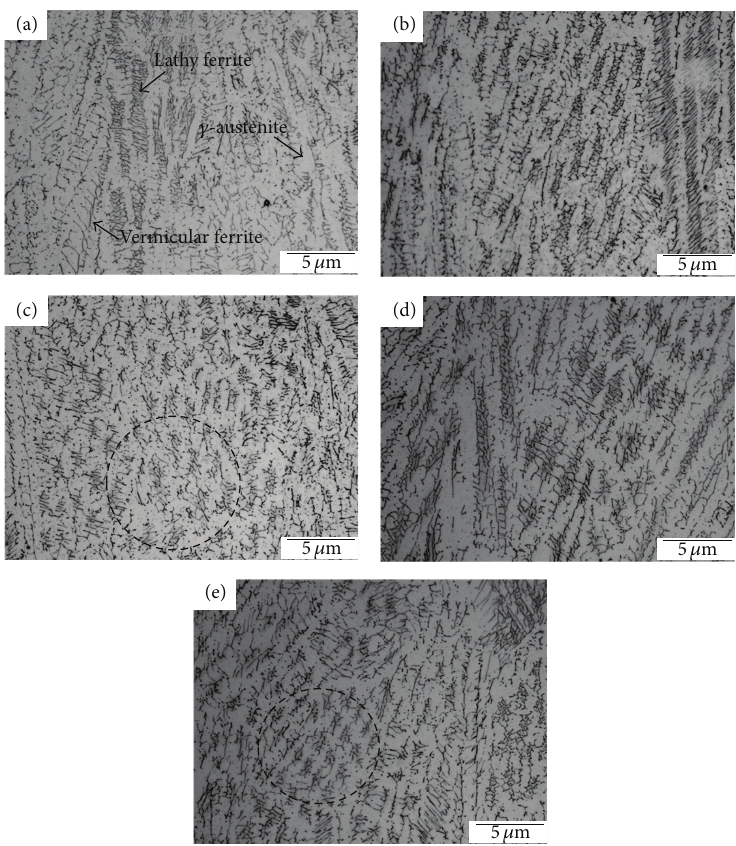
Figure11:Themorphologiesofthe 𝛿 -ferritewithtwovibrationmodes:(a)0 Hz(b)TX-VSR362 Hz,(c)TX-VSR375 Hz,(d)Meta-Lax59.3 Hz, and (e) Meta-Lax 60.9